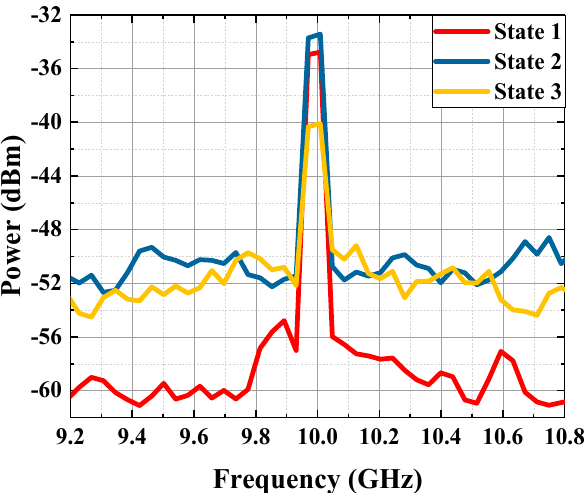
Figure 6. Electrical spectrum of the proposed all-optical microwave frequency divider, with the f target is 10